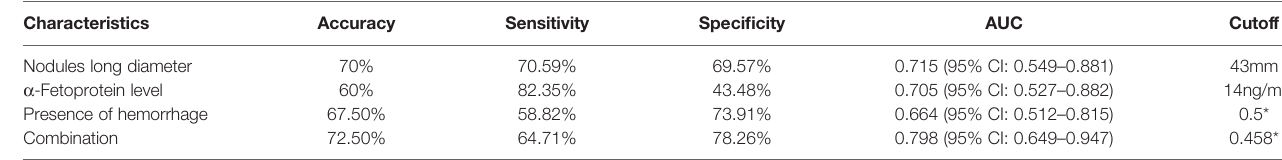
TABLE 3 | Performance of three clinical variables in the test cohort whereas cutoff is determined in the training cohort using Youden Index. Characteristics